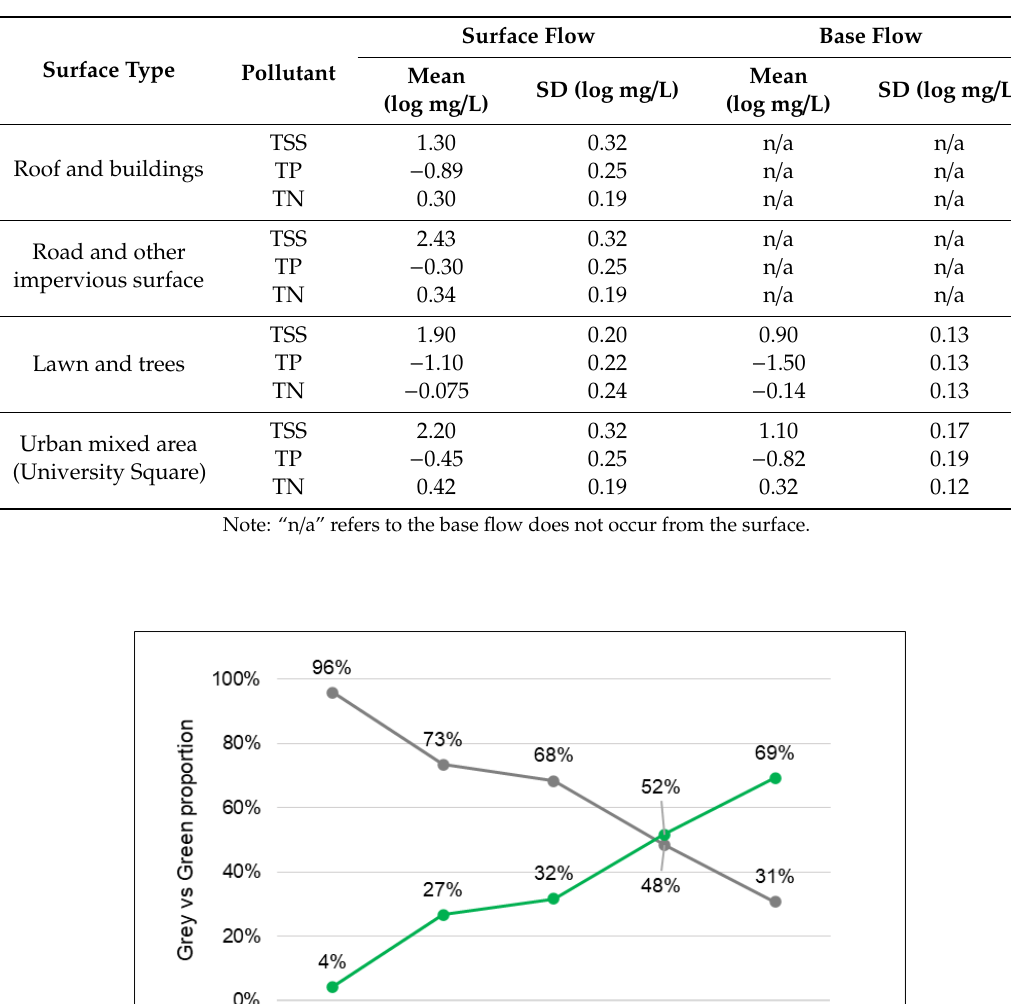
Table 5. Gaussian Distribution parameters of pollutants total suspended solid (TSS), total phosphorus (TP), and total nitrogen (TN).